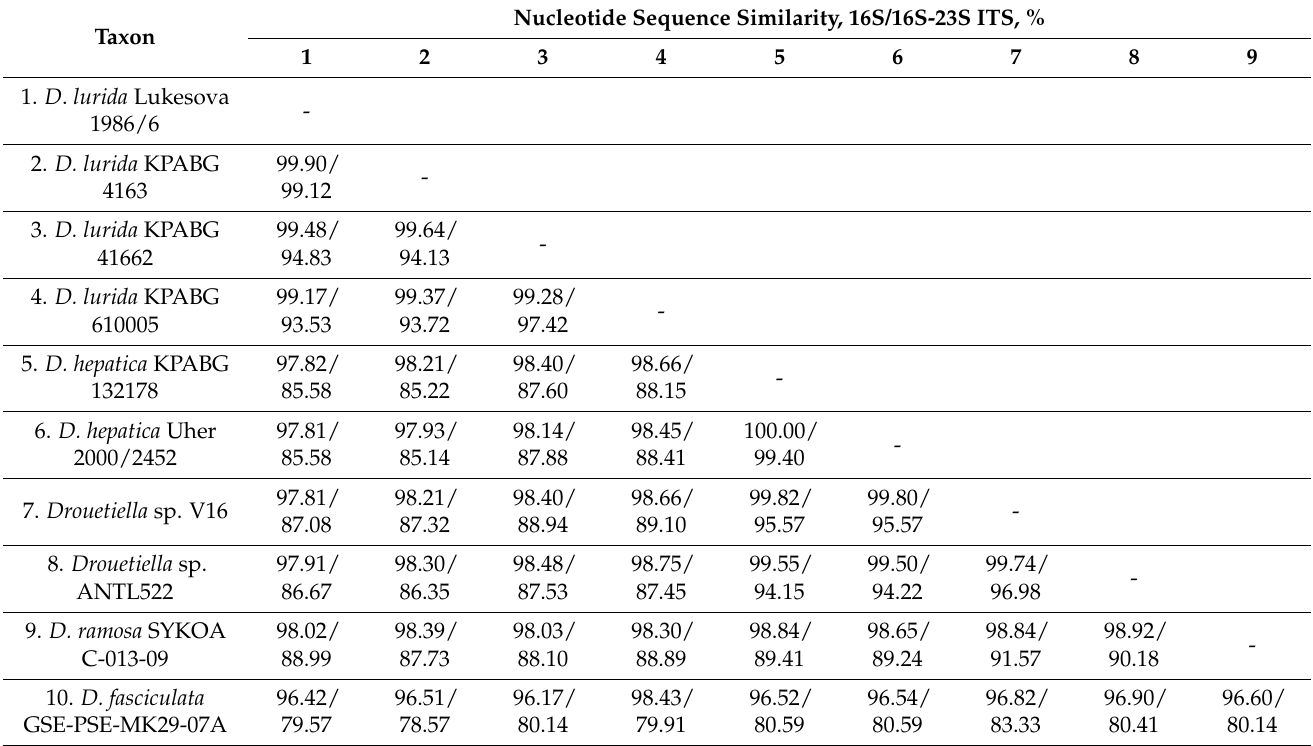
Table 3. The nucleotide sequence similarity for the genus Drouetiella strains, based on the nucleotide sequence data of the 16S rRNA gene and 16S-23S ITS rRNA region,